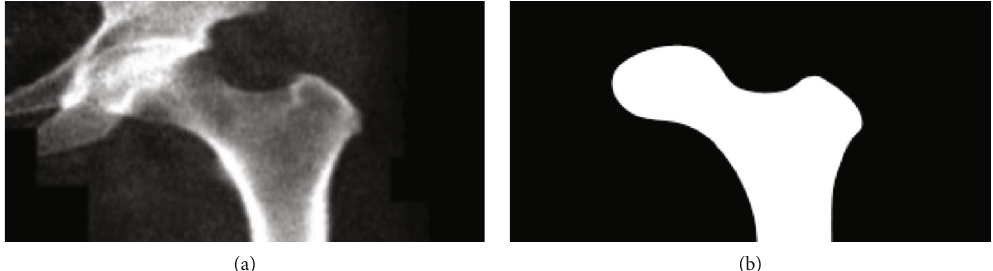
Figure 1: Original image from the iDXA densitometer database enhanced by a Gaussian fi lter (a). Manually segmented image (b).